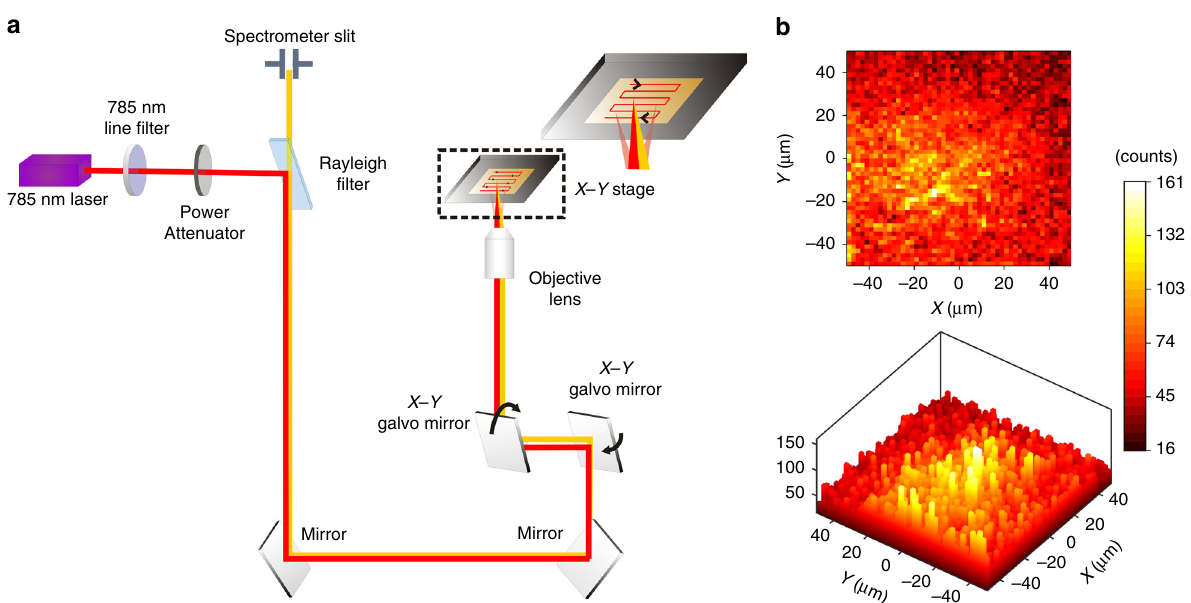
Fig. 6 High-speed readout of PUF labels. a Schematic of con fi gurations of Raman system used for high-speed scanning. Under the DuoScan mode, two galvo mirrors rotate along two orthogonal axes in the mirror plane, controlling movements of the laser spot along the x - and the y- axis, respectively. b Two- dimensional (2D) (top) and 3D (bottom) plot for a PUF label (100 × 100 μ m 2 ) read in DuoScan mode in 6 s with a resolution of 50 × 50